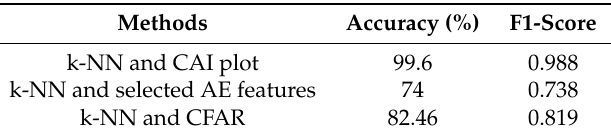
Table 2. Performance comparison of the di ff erent approaches. K-NN: k-nearest neighbor, CAI: crack assessment indicator, and AE: acoustic